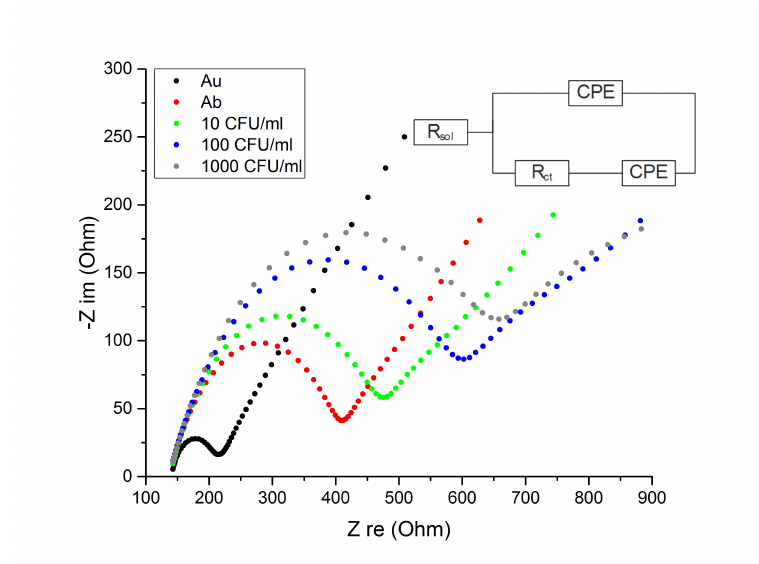
Figure 3. Nyquist plot for clean gold (Au-black), antibody modified (Ab-red) and each tested C. albicans concentration with 10, 100 and 100 CFU/mL (green, blue and grey respectively). The data is fitted to the modified Randles equivalent